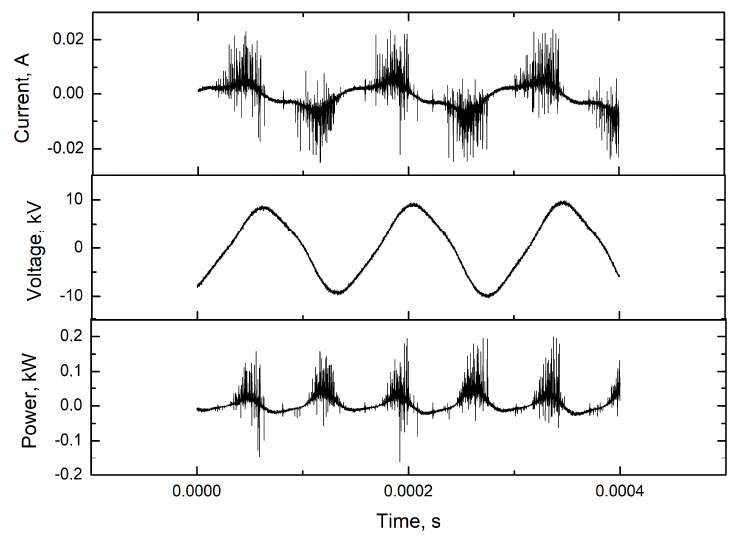
Figure 3. An example of a discharge current-voltage characteristic.